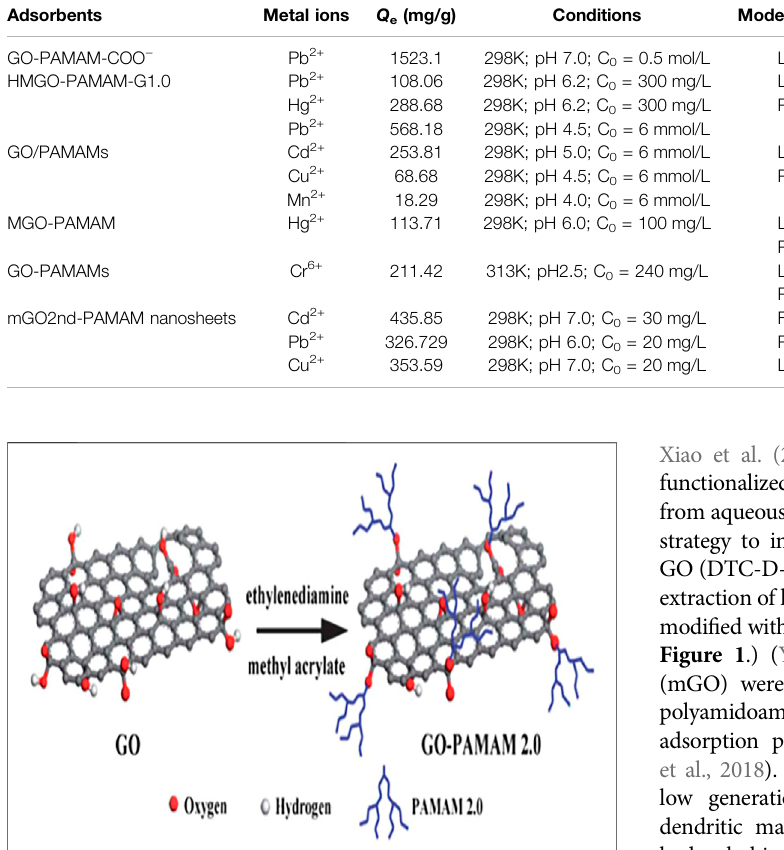
FIGURE 1 | Illustration of the preparation of GO-PAMAM 2.0.